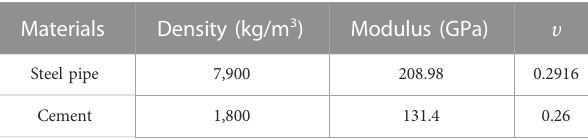
TABLE 1 Mechanical property parameters of cementing casing material.